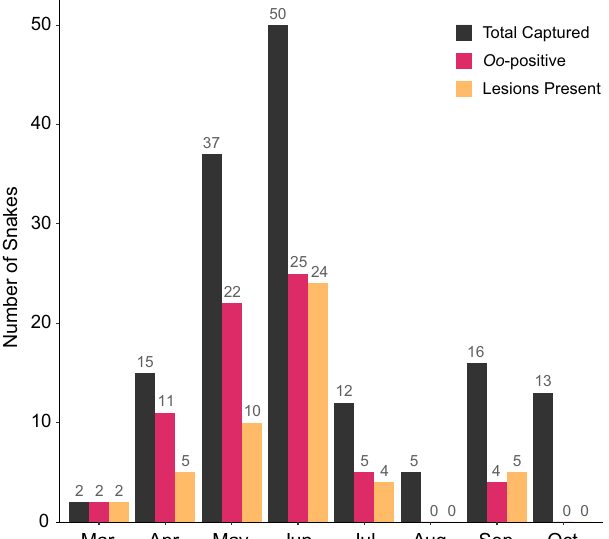
Figure 3. Histogram of the total number of snakes captured per month, the number of snakes that tested positive for Ophidiomyces ophiodiicola via qPCR, and the number of snakes showing signs of infection. Surveillance efforts were performed from 16 April 2018 through 6 October 2020.